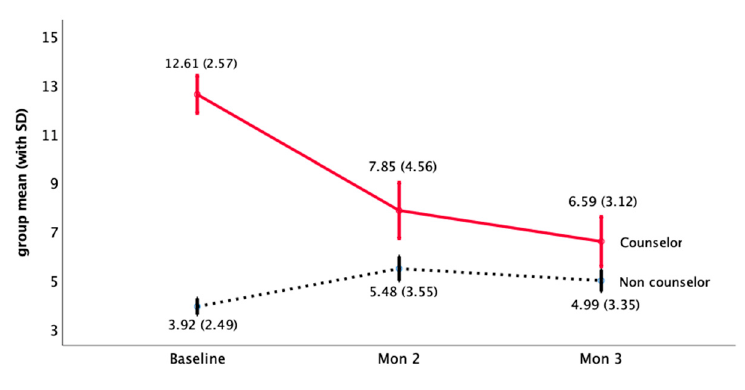
Figure 3. Mental health distress score trend of NGNs receiving gentle care counseling. Table 3. Analysis of the mental health distress of NGNs receiving gentle care and